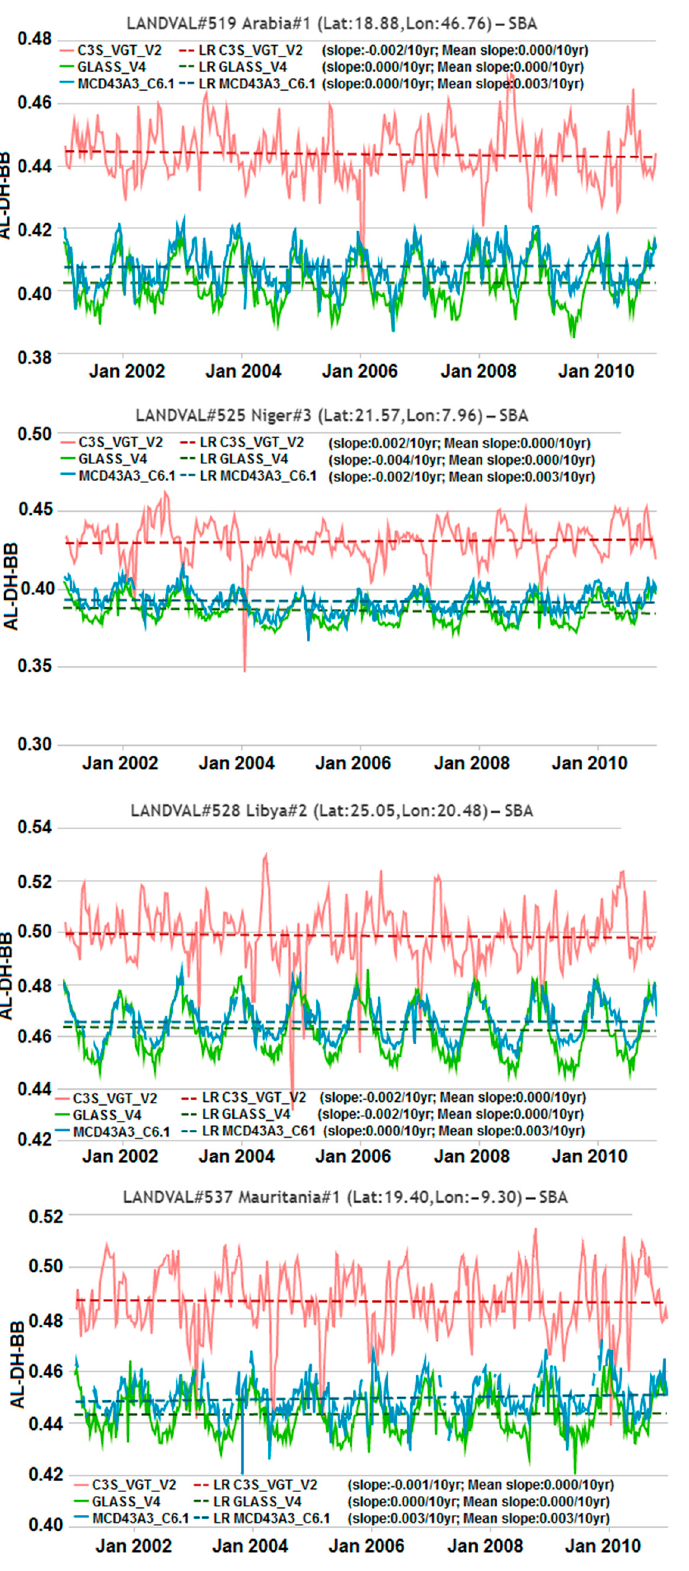
Figure 13. Examples of temporal profiles of C3S V2 (red), GLASS V4 (green), and MCD43A3 C6.1 (blue) for black-sky total shortwave albedos over calibration sites of LANDVAL in the 2001–2010 period for best quality pixels. Dashed lines represent the linear regression of each product trend. Mean slope value corresponds to the mean slope considering all calibration sites.